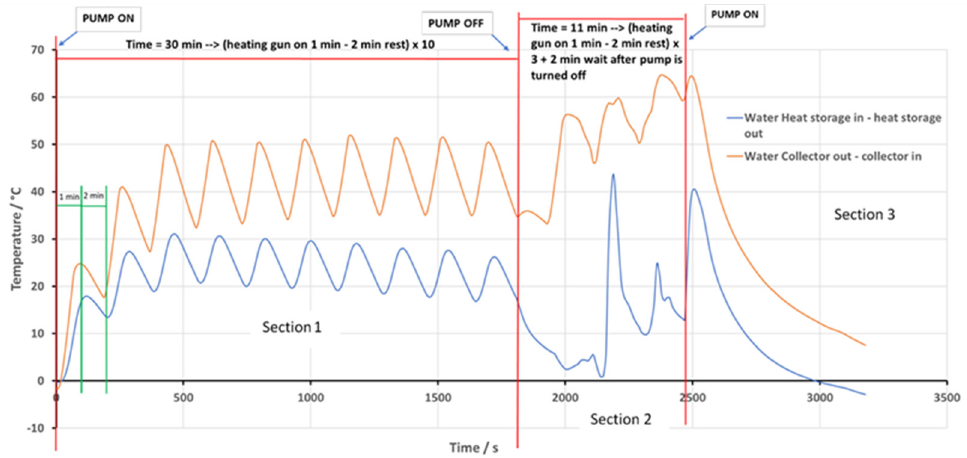
Figure 5. The temperature profiles in the storage reservoir (in blue), and in the heat collector (in orange), as a function of time, expressed as T out − T in , in K, for a run with